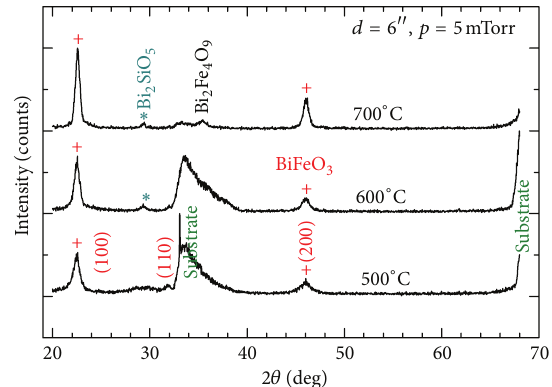
Figure 3: XRD patterns of bismuth ferrite films deposited Ar gas pressure 𝑝 = 5 mTorr at a distance 𝑑 = 6 󸀠󸀠 on oxidized Si wafers. The films show (100) texture of the pseudocubic unit cell which corresponds to the (012) of